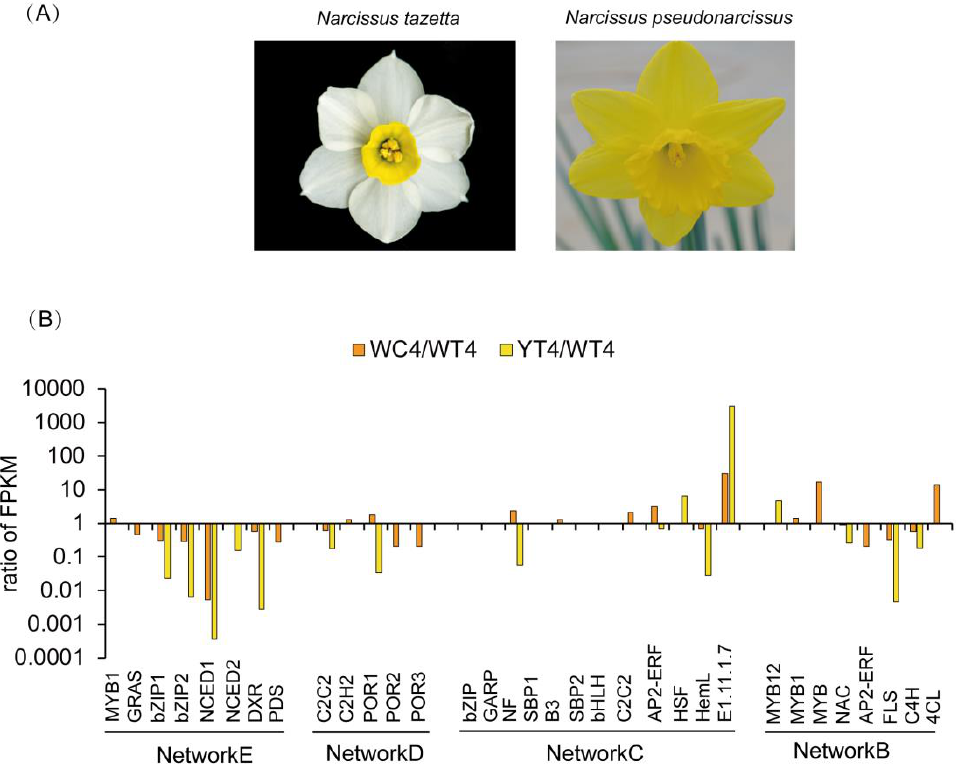
Figure 8. Expression pattern of candidate TFs in Narcissus tazetta and Narcissus pseudonarcissus by RNA-seq dataset. ( A ). Flowers of Narcissus tazetta and Narcissus pseudonarcissus at T4 stage. ( B ). Ratio of FPKM from the RNA-seq dataset of coronas, tepals of Narcissus tazetta and tepals of Narcissus pseudonarcissus at T4 stage. WC4, coronas of Narcissus tazetta at T4 stage, WT4, tepals of Narcissus tazetta at T4 stage; YT4, tepals of Narcissus pseudonarcissus at T4 stage. Network B-E refer to Figure 7B-E .